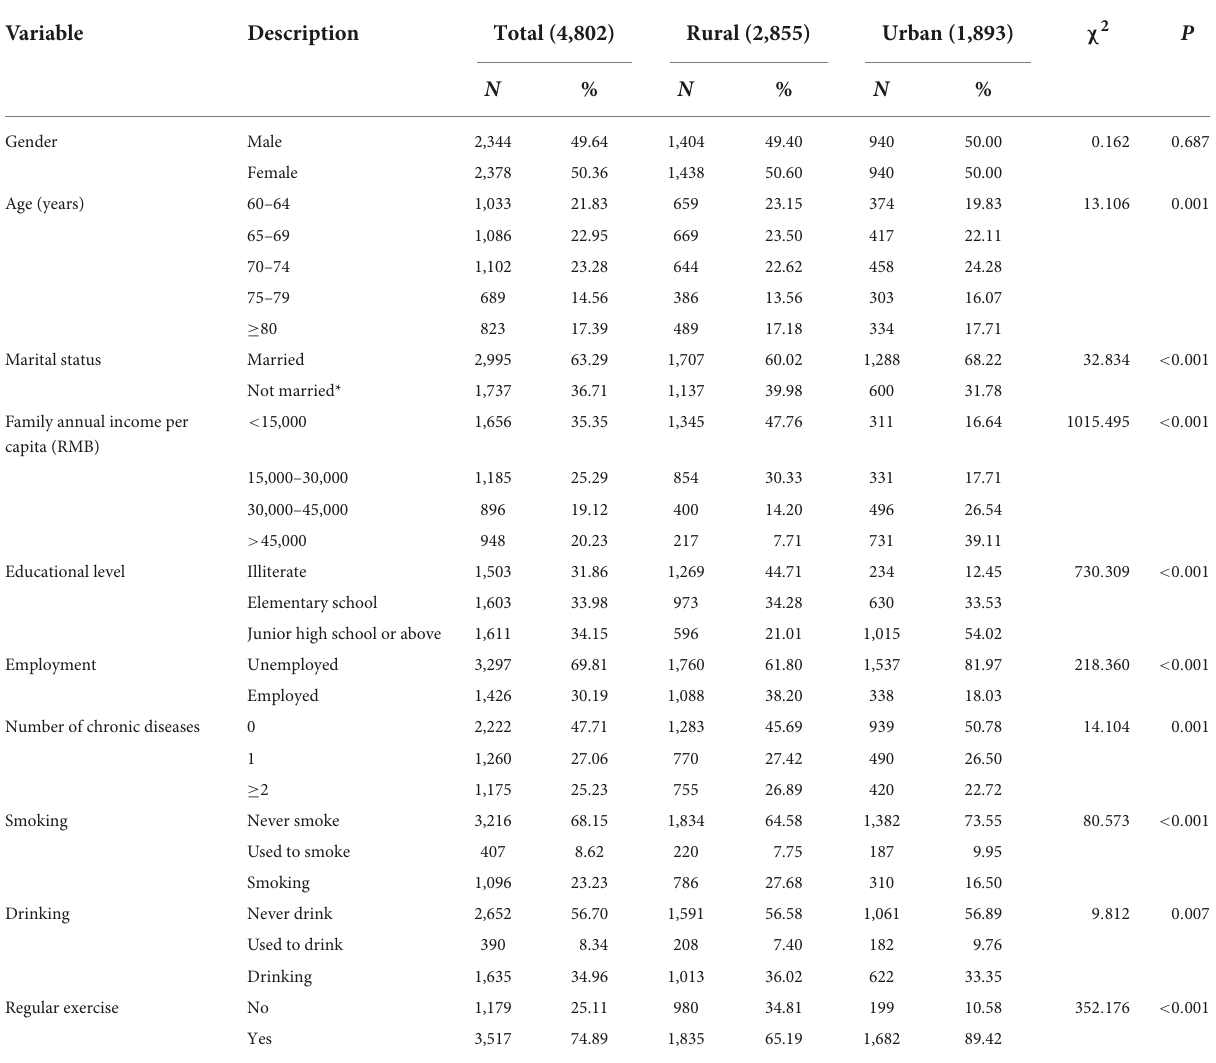
TABLE 1 Sociodemographic characteristics of